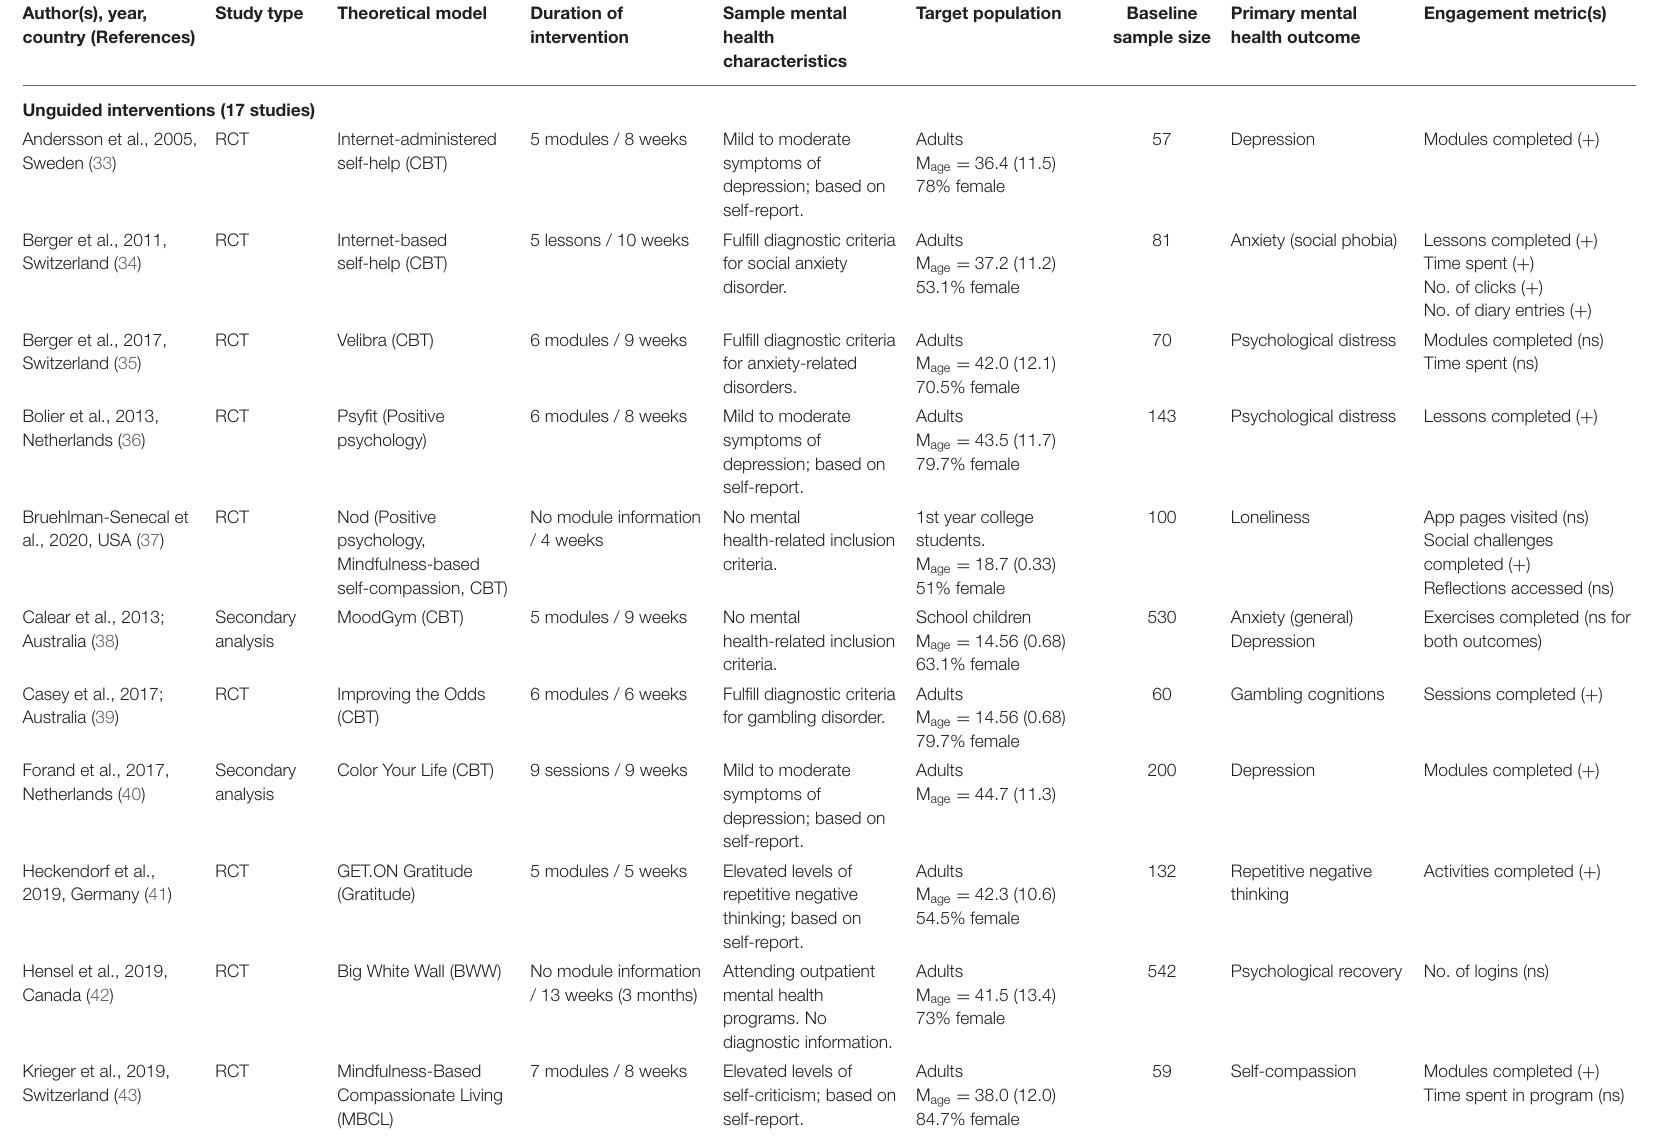
TABLE 1 | Characteristics of the included